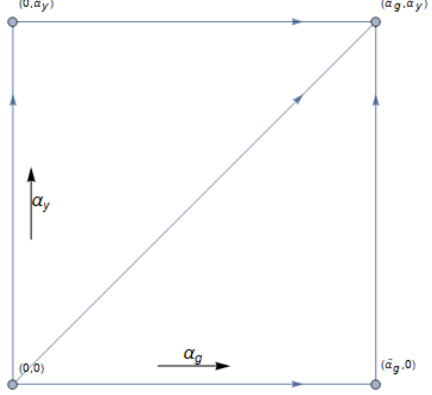
Figure 19. Topology of the RG-(cid:13)ow between 4 (cid:12)xed